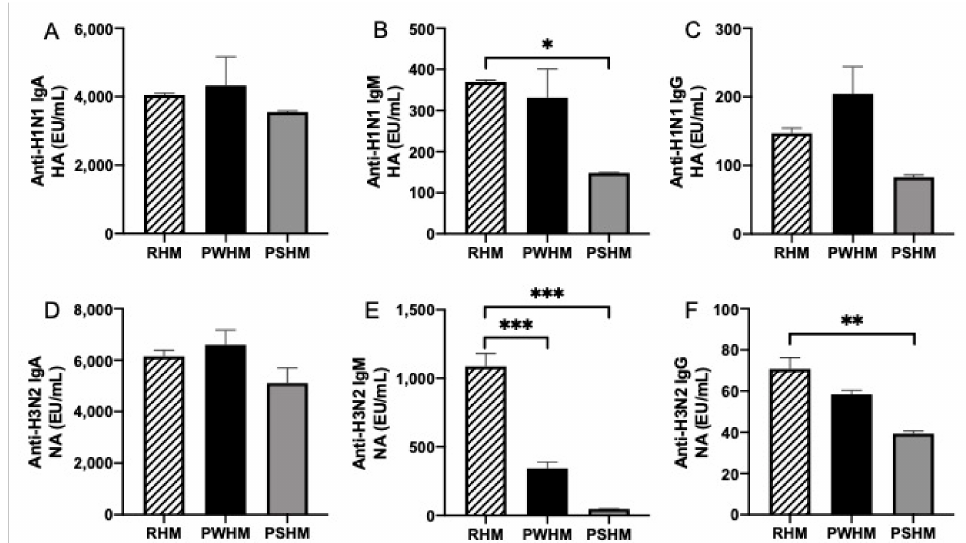
Figure 4. Comparison of immunoglobulin relative abundance between raw human milk (RHM) and pasteurized whole human milk (PWHM) or pasteurized skimmed human milk (PSHM) ( n = 3). Relative abundance of anti-H1N1 HA ( A ) IgA, ( B ) IgM, ( C ) IgG, and of anti-H3N2 NA. ( D ) IgA, ( E ) IgM, and ( F ) IgG in mother’s milk. Milk samples were from one mother who delivered one term infant at 38 wk of GA and collected milk at 12 days of postnatal age. Asterisks show statistically significant di ff